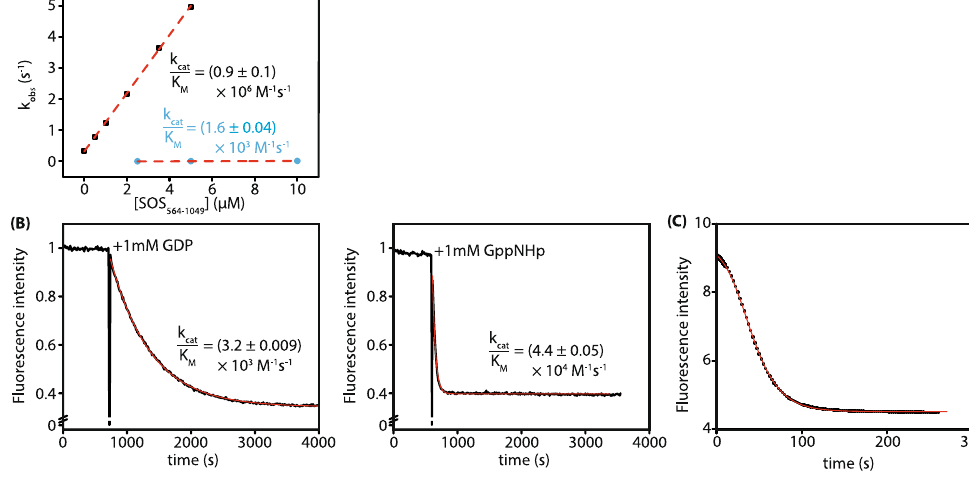
Figure 3. SOS catalyzed nucleotide exchange. ( A ) Comparison of SOS catalyzed nucleotide exchange on 0.2 µ M KRas:mantdGDP (turquoise) or 0.2 µ M KRas:mantdGDP β Me (black) in the presence of varying excess SOS concentrations. Linear fits yield k cat /K M values of 1.6 × 10 3 M − 1 s − 1 and 0.9 × 10 6 M − 1 s − 1 , respectively. ( B ) In order to quantify the effects of SOS activation via the allosteric Ras binding site, 10 µ M Ras:mdGDP/0.5 µ M SOS 564–1049 were preincubated in a cuvette and the reaction was started by addition of 1 mM GDP (left) or 1 mM GppNHp (right). The large difference in the velocity of the two exchange reactions is due to Ras binding to the allosteric site only in the active GppNHp-bound form. Because of the high velocity under the conditions chosen, the intial change in amplitude could not be observed upon exchange with GppNHp. ( C ) Reaction as in B repeated in a stopped-flow device. 10 µ M Ras:mdGDP was shot against 1 µ M SOS 564–1049 and 1 mM GppNHp. The sigmoidal shape of the beginning of the curve arises from allosteric activation by the generated